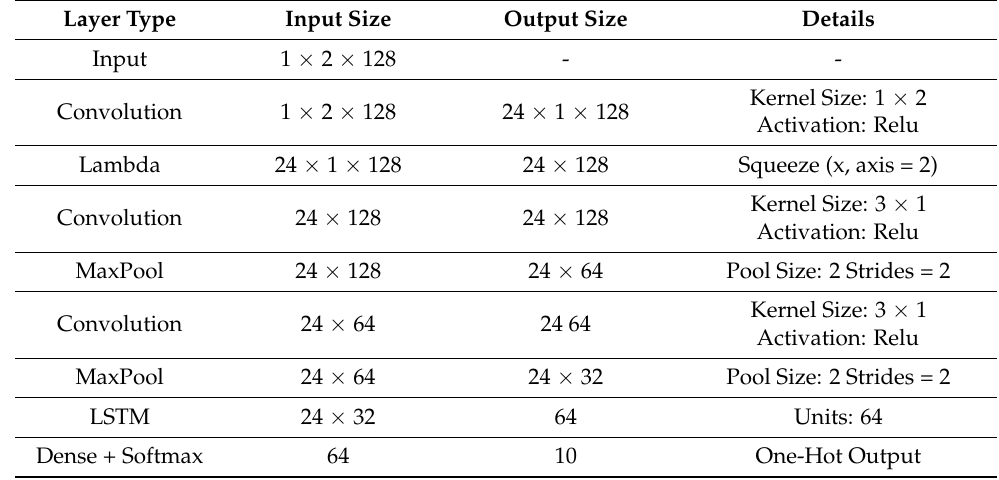
Table 1. The structure of the IQCLNet